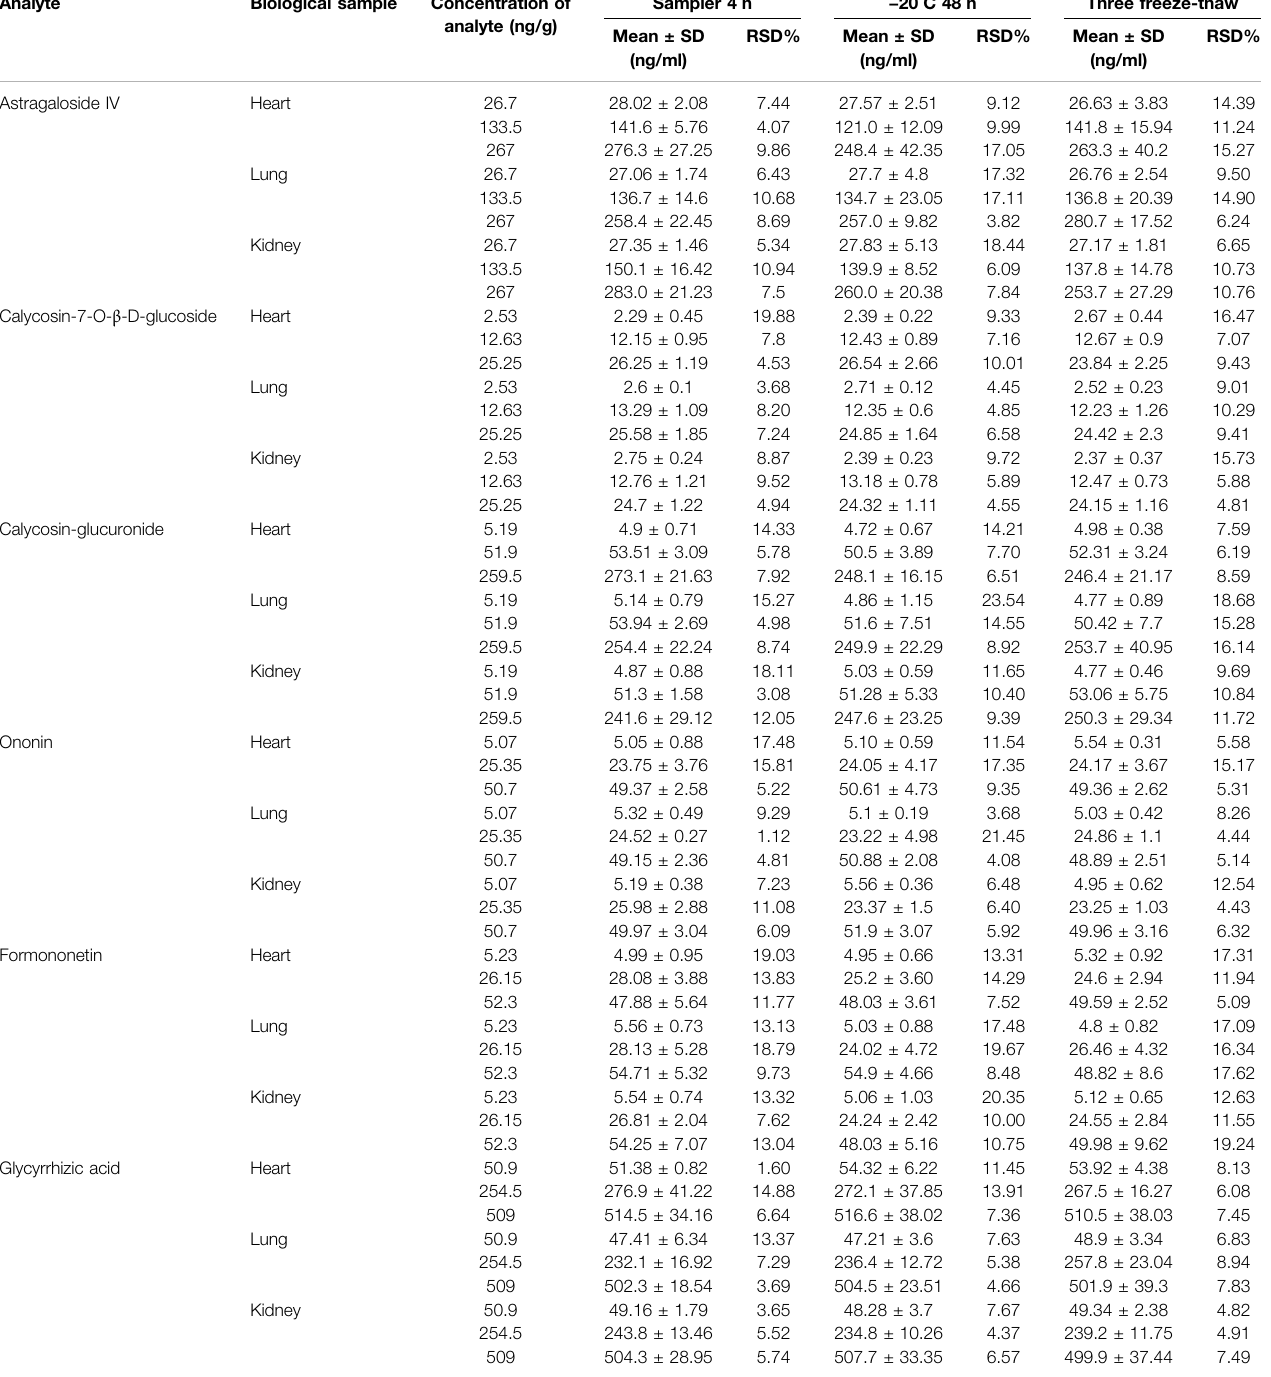
TABLE 5 | Stability of ingredients in tissue homogenate samples (x ± SD; n = 6). Analyte Biological